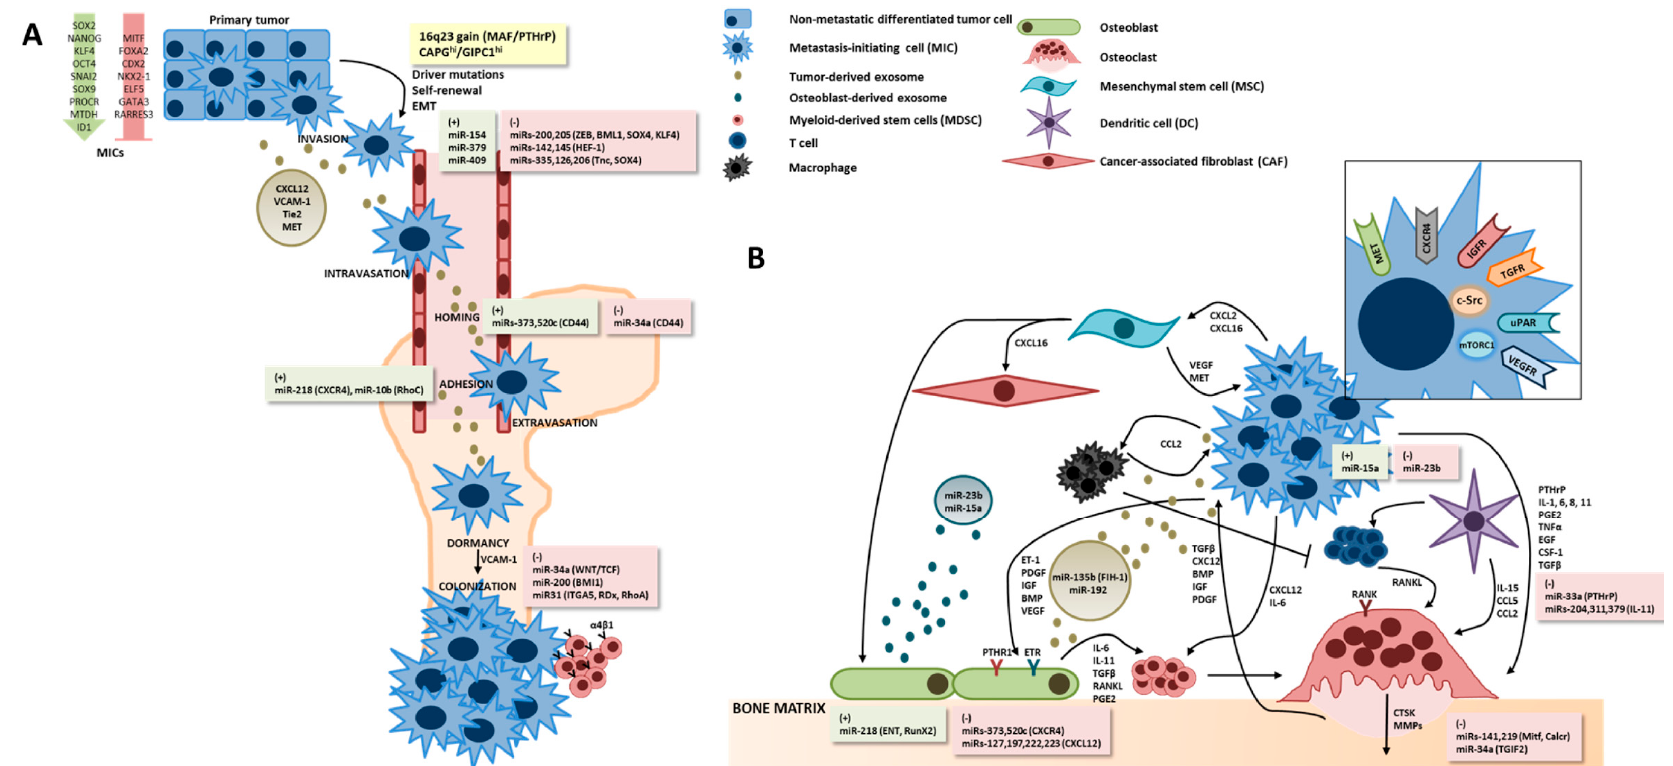
Figure 1. Molecular players of the metastasis formation cascade in the bone ( A ) and “bone vicious cycle” ( B ). ( A ) Metastasis-initiating cells (MICs) are a small fraction of long-term self-renewing tumor-initiating cells, characterized by specific driver mutations and high cellular plasticity [22]. Osteotropic events, like the 16q23 gain or macrophage-capping protein (CAPG)/ PDZ domain-containing protein GIPC1 (GIPC1) overexpression, will occur at early stages of tumor development [23,24]. Exosomes released from the primary tumor can facilitate the establishment of the pre-metastatic niche by transporting cytokines or being involved in gene transfer [22]. Upon the dormancy phase, vascular cell adhesion molecule 1 (VCAM-1) promotes osteolytic expansion of indolent bone micrometastases by engaging α 4 β 1-positive osteoclast progenitors [25]; ( B ) the “vicious-cycle of bone metastases” results from the complex interaction between tumor cells, bone forming osteoblasts, bone resorbing osteoclasts, and a variety of cells from the bone microenvironment and immune system, like cancer-associated fibroblasts (CAFs), mesenchymal stem cells (MSCs), dendritic cells (DCs), T cells and macrophages [26]. Osteoblasts are activated by tumor-derived parathyroid hormone-related protein (PTHrP), leading to increased production of receptor activator of nuclear factor kappa-B ligand (RANKL). RANKL binds to receptor activator of nuclear factor kappa-B